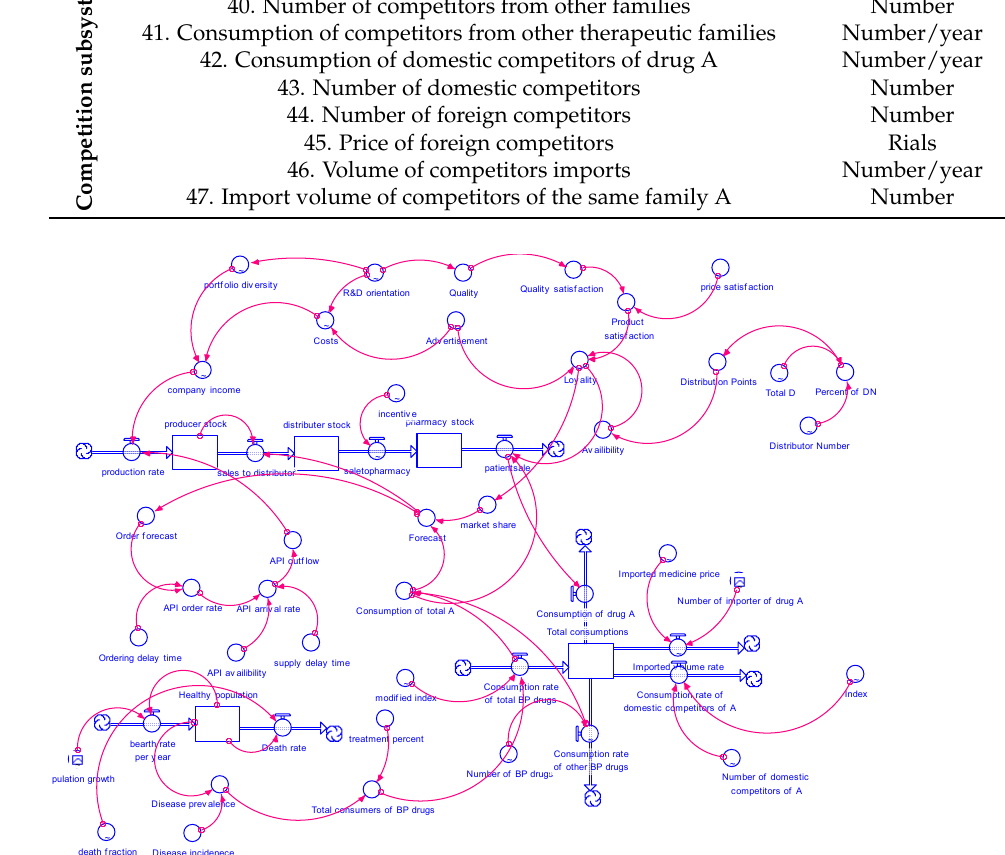
Figure A2. Stock and flow diagrams of generic pharmaceutical PLC in Stella software 8.0. Notes: Some assumption was considered to develop the system dynamic model: (1) The drug is a prescription medicine. (2) Iran’s FDA sets the price of all generic medicines, and the medicine are under the insurance coverage, so all of the producers’ price are the same and price satisfaction was considered 100%).